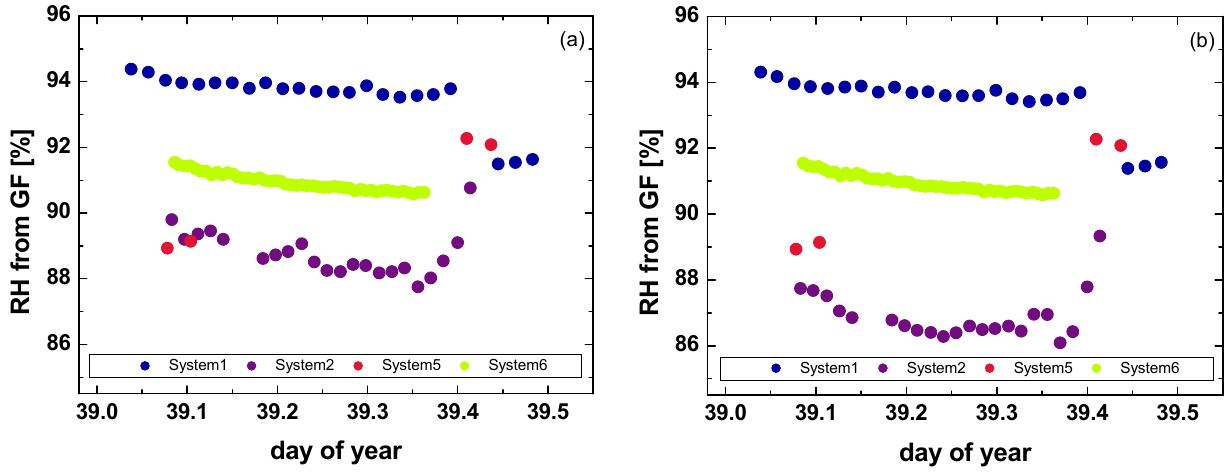
Fig. 4. Time series of (a) externally and (b) internally evaluated RH difference for all systems measured at a dry diameter of Dp =50nm. The set point during this experiment was RH=90%.